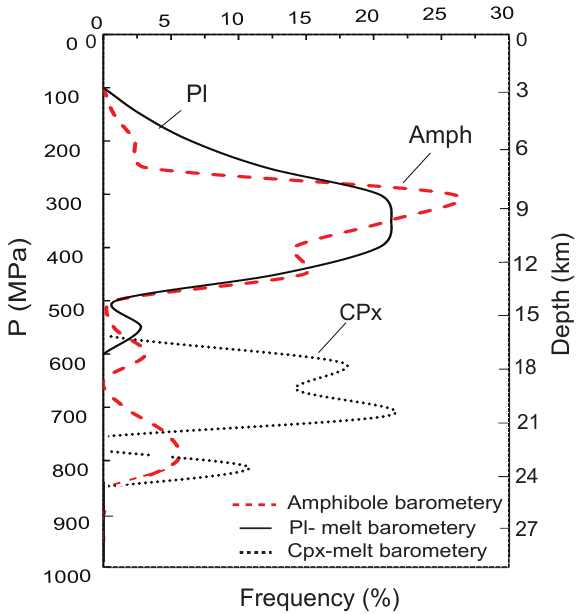
Fig. 16 Figure 16. A comparison of the results of amphibole, plagioclase– melt and clinopyroxene–melt barometries that indicate two distinct magma storage regions in the crust, one around a depth of ∼ 6–9km and the other at ∼ 18–27km